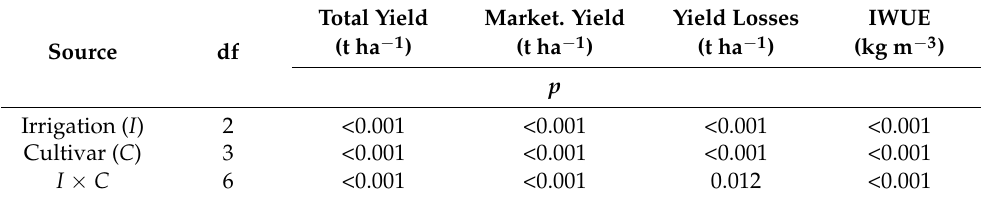
Table 1. ANOVA results for fruit yield and IWUE in four cultivars of tomato in relation to the irrigation treatments. Degree of freedom (df).